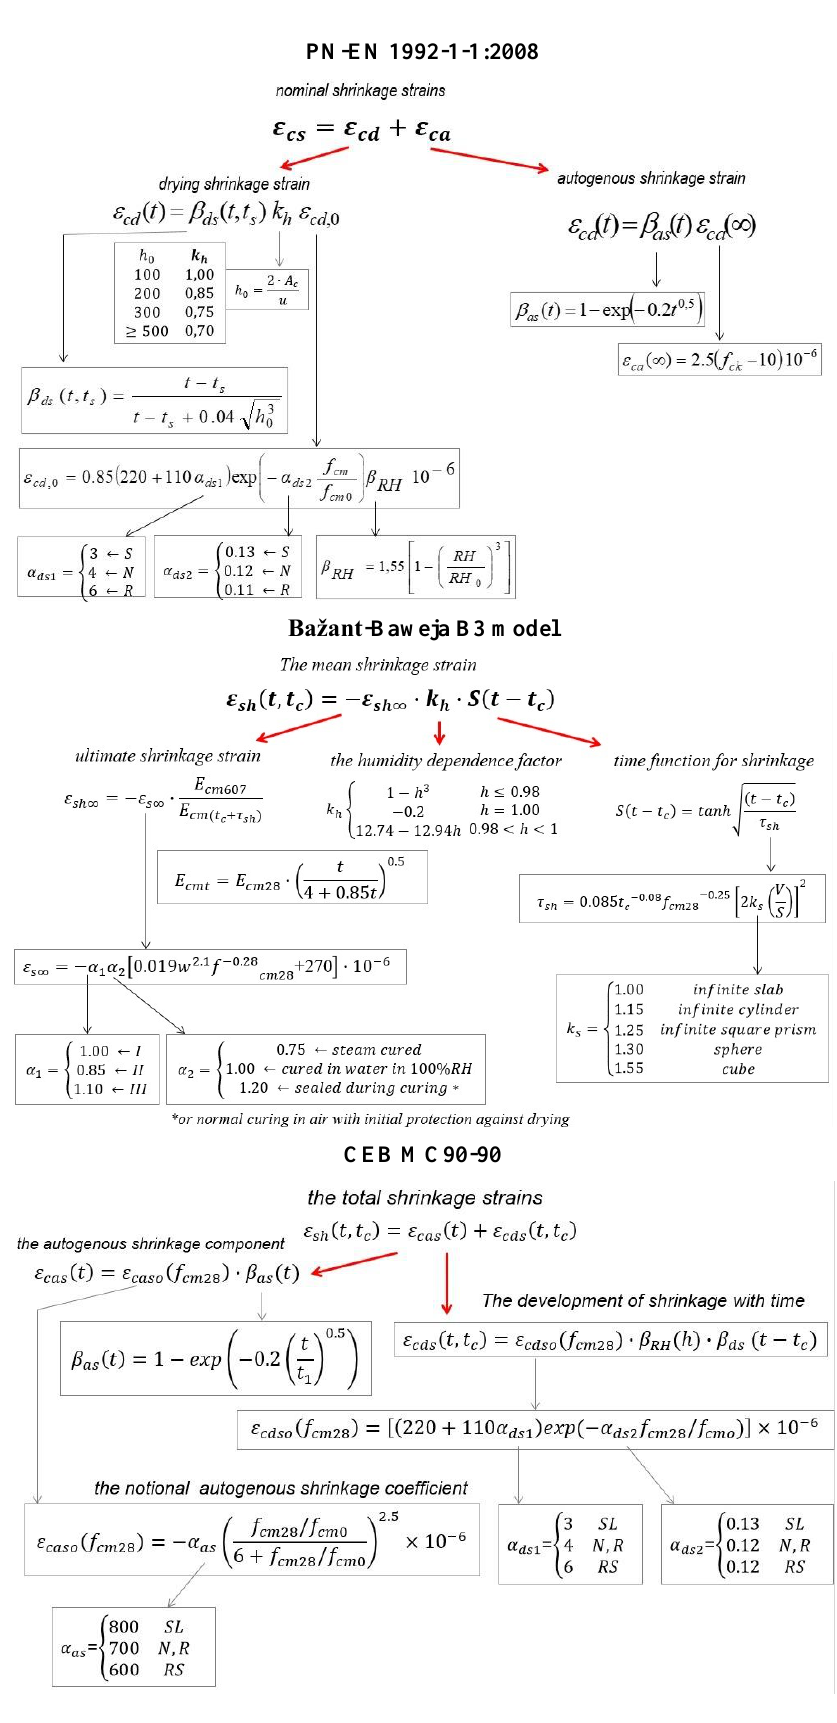
Figure 4. Procedures for predicting shrinkage strain according to selected standards.